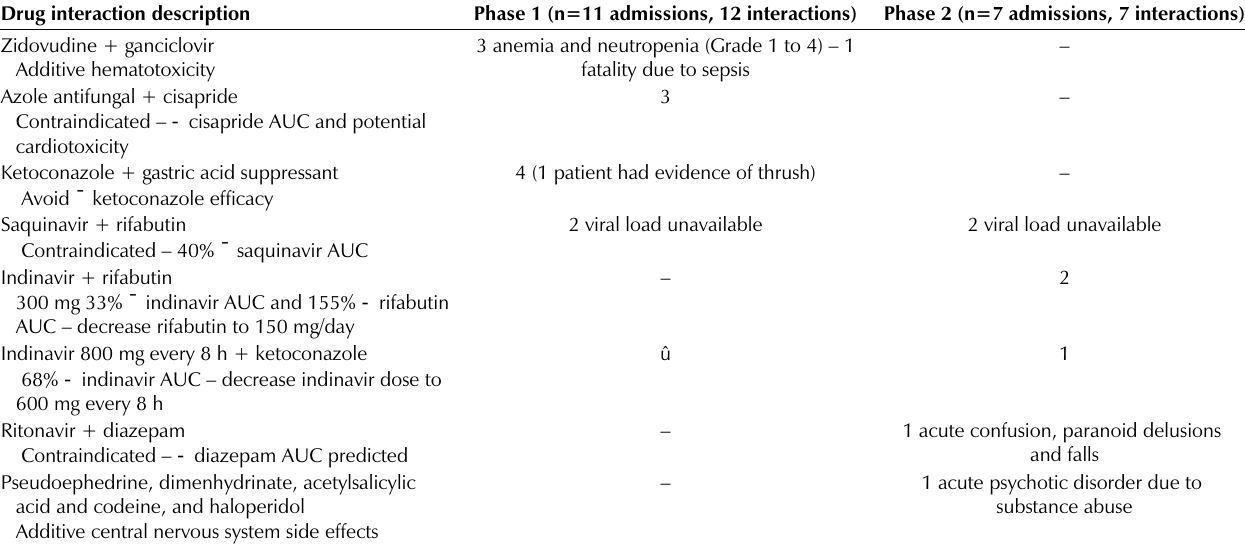
Pseudoephedrine, dimenhydrinate, acetylsalicylic acid and codeine, and haloperidol Additive central nervous system side